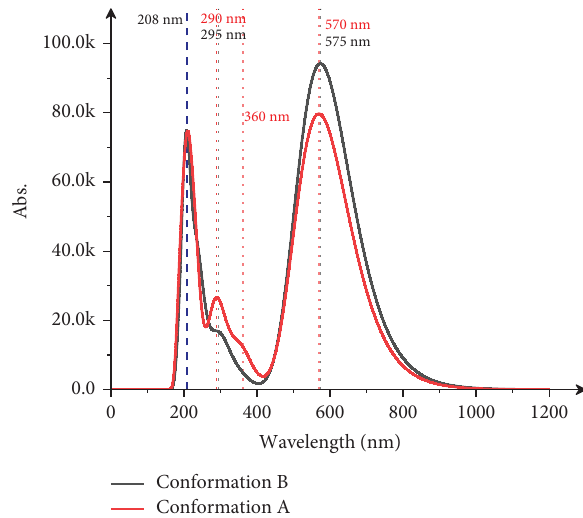
Figure 4: Teoretical UV-vis spectra of two diferent conformations of ICG